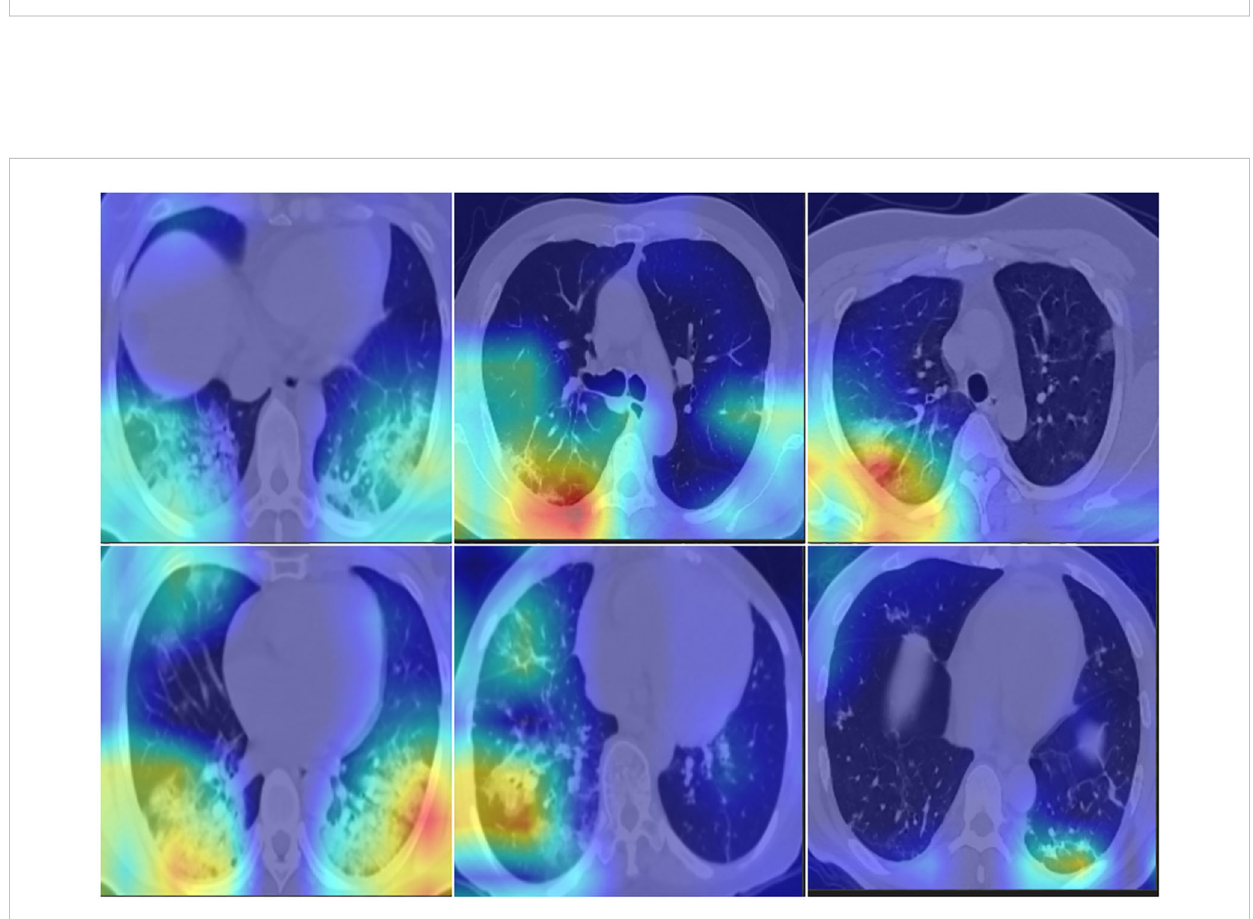
FIGURE 3 The ROC cure comparison of the two experiment results of resnet50 with GAP and with mask weighted GAP. Vertical axis is false positive rate, while horizontal axis is true positive rate. The blue cure is the result of mask weighted GAP, while the red cure is the result of GAP.